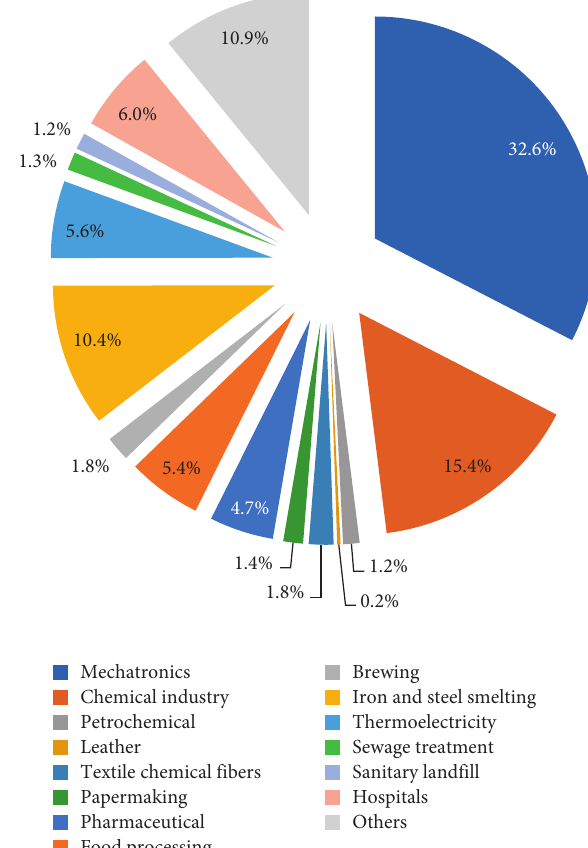
Figure 12: Classification of potential pollution enterprises in Jinan